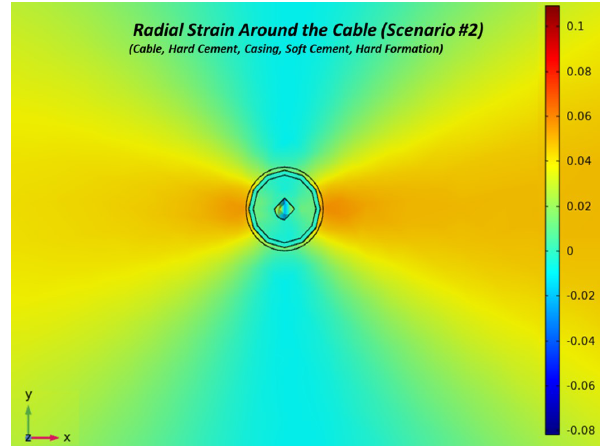
Figure 6. Radial strain around the cable as a response of compres- sional wave propagation at a 90 ◦ incident angle in scenario 2 (inci- dent waveform is incoming from the